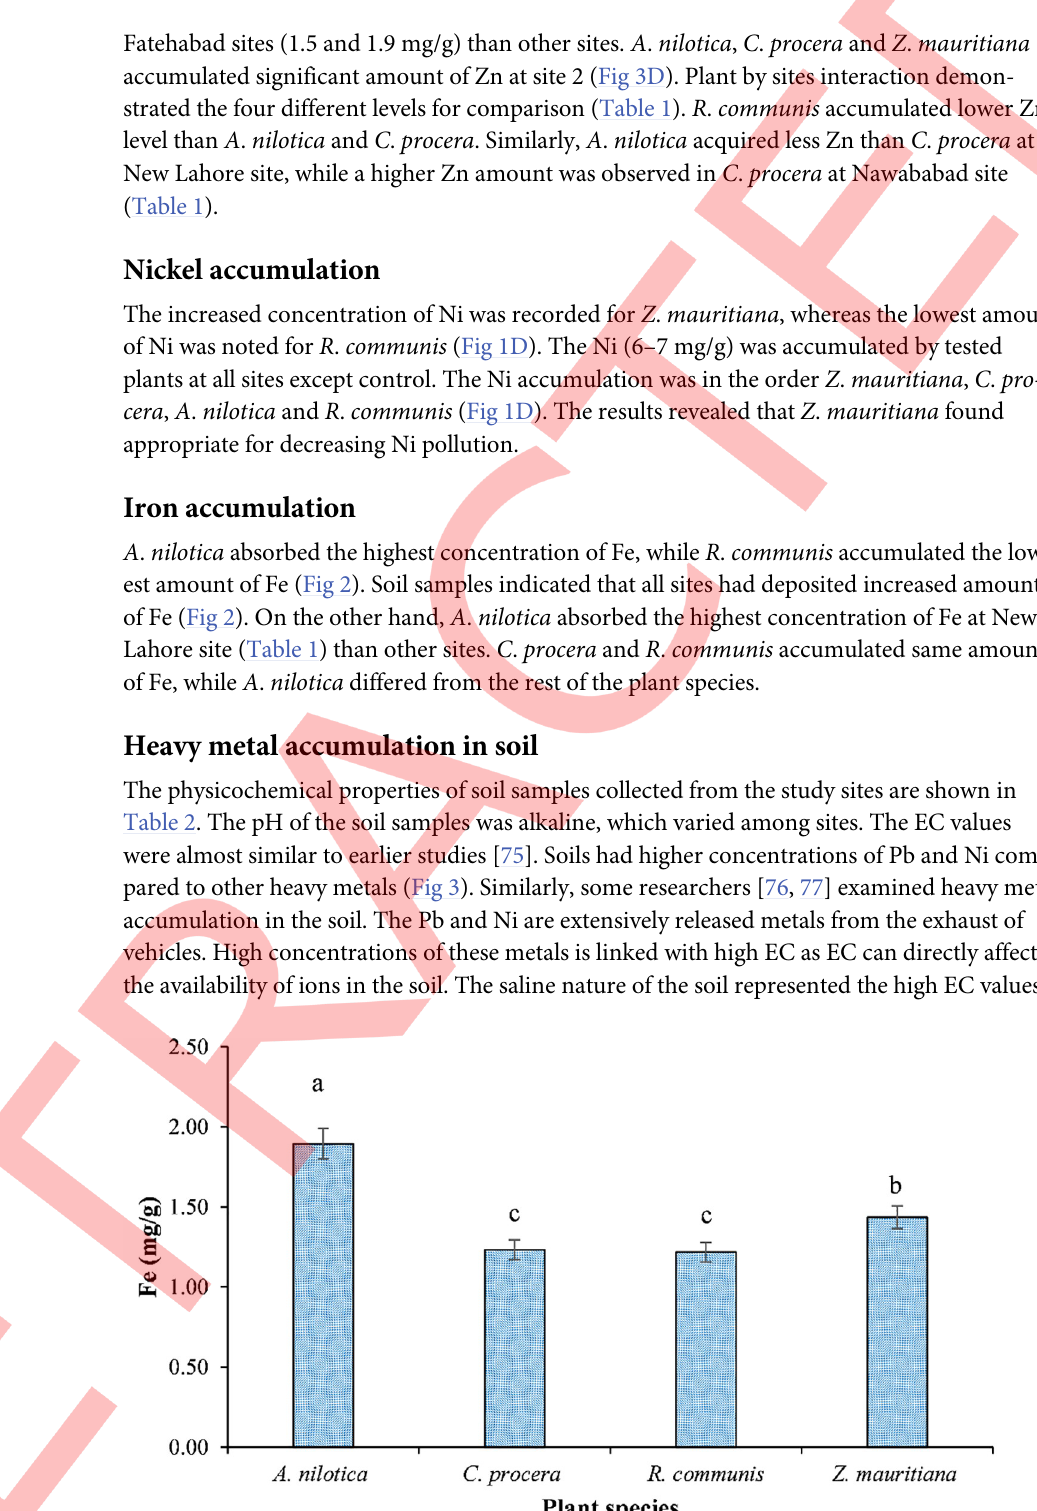
Fig 2. Iron accumulation in in different wild plant species growing on roadside in a heavy automobile emission area, means sharing same letters are statistically non-significant (p > 0.05).